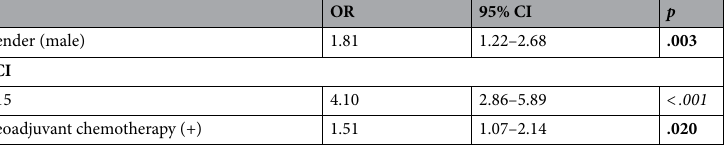
Table 3. Preoperative factors independently associated with ileal resection in multivariate analysis. PCI peritoneal carcinomatosis index. Significant values are in bold and italics.